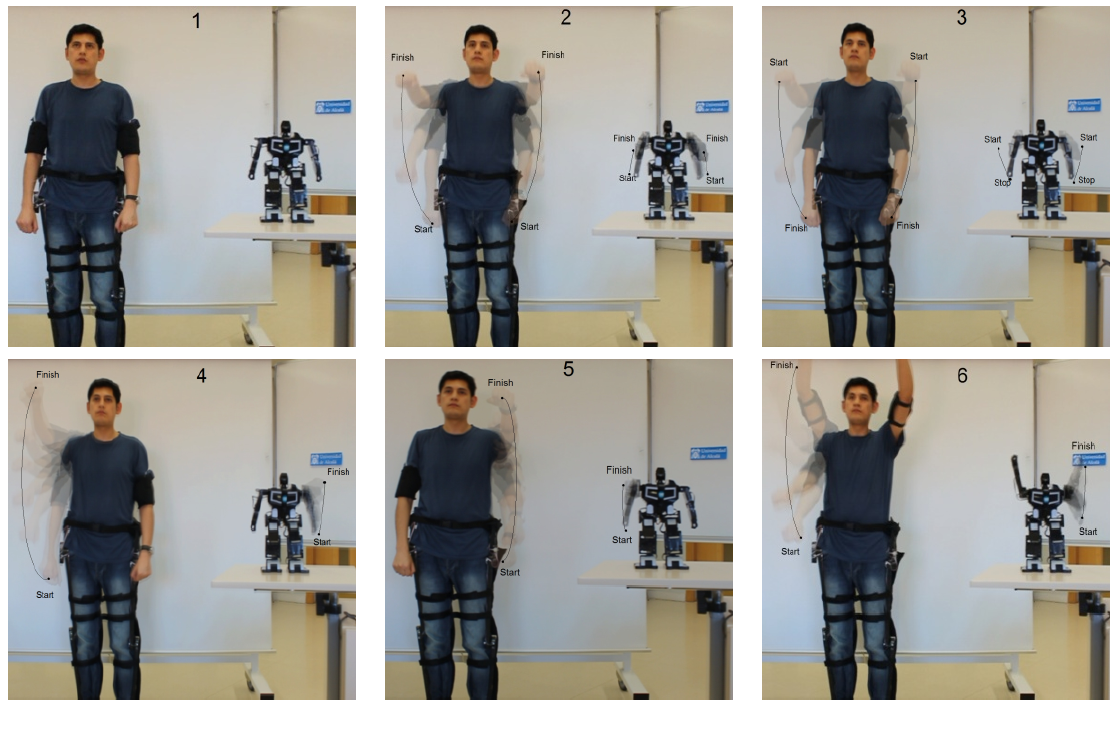
Figure 12. Sample movement sequence. ( a ) Down; ( b ) Moving up; ( c ) Moving down; ( d ) Right shoulder up; ( e ) Left shoulder up; ( f ) Both shoulders